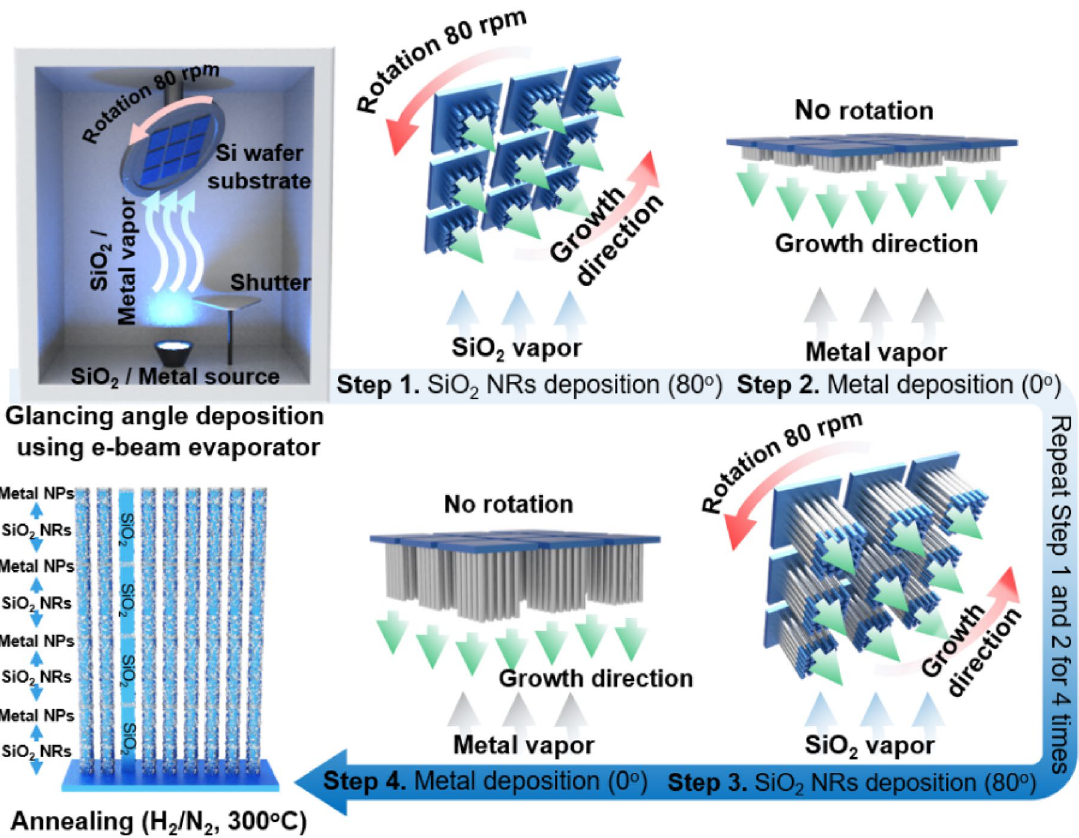
Figure 1. Synthetic procedure of v-SiO 2 NRs@Pd nanostructured